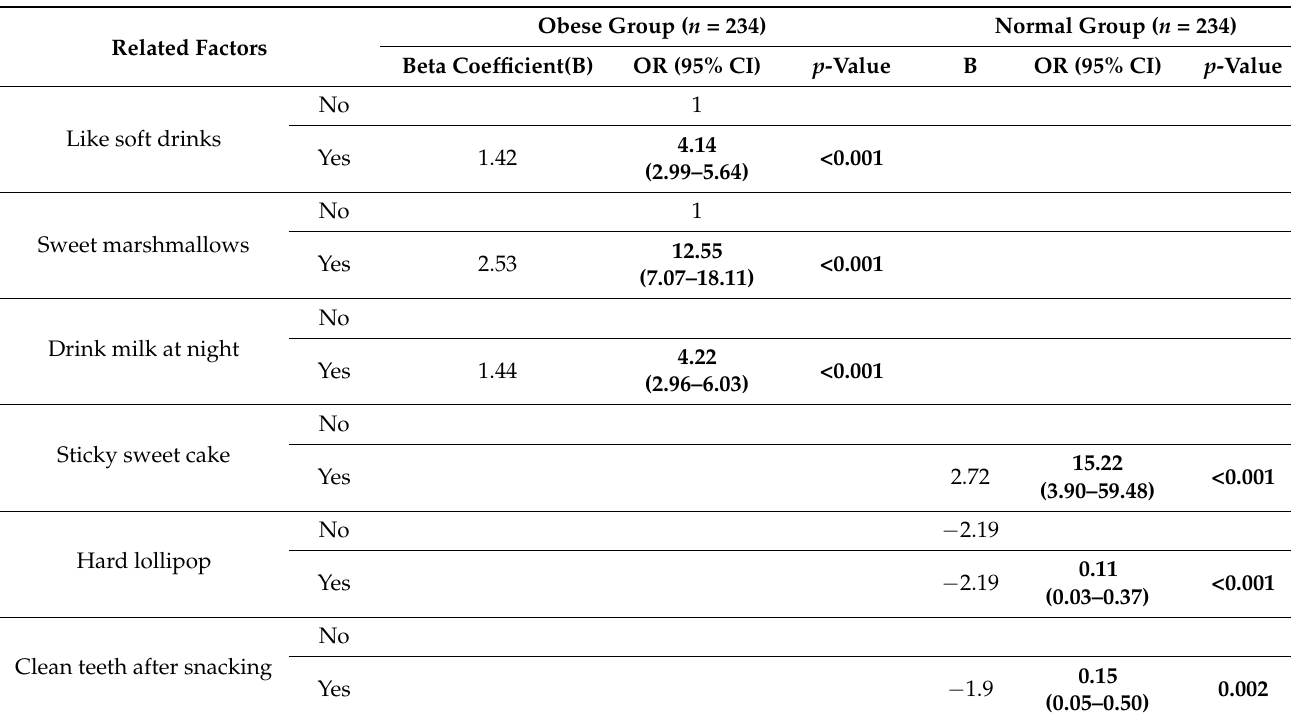
Table 4. Multivariate regression analysis in the Obese and Normal